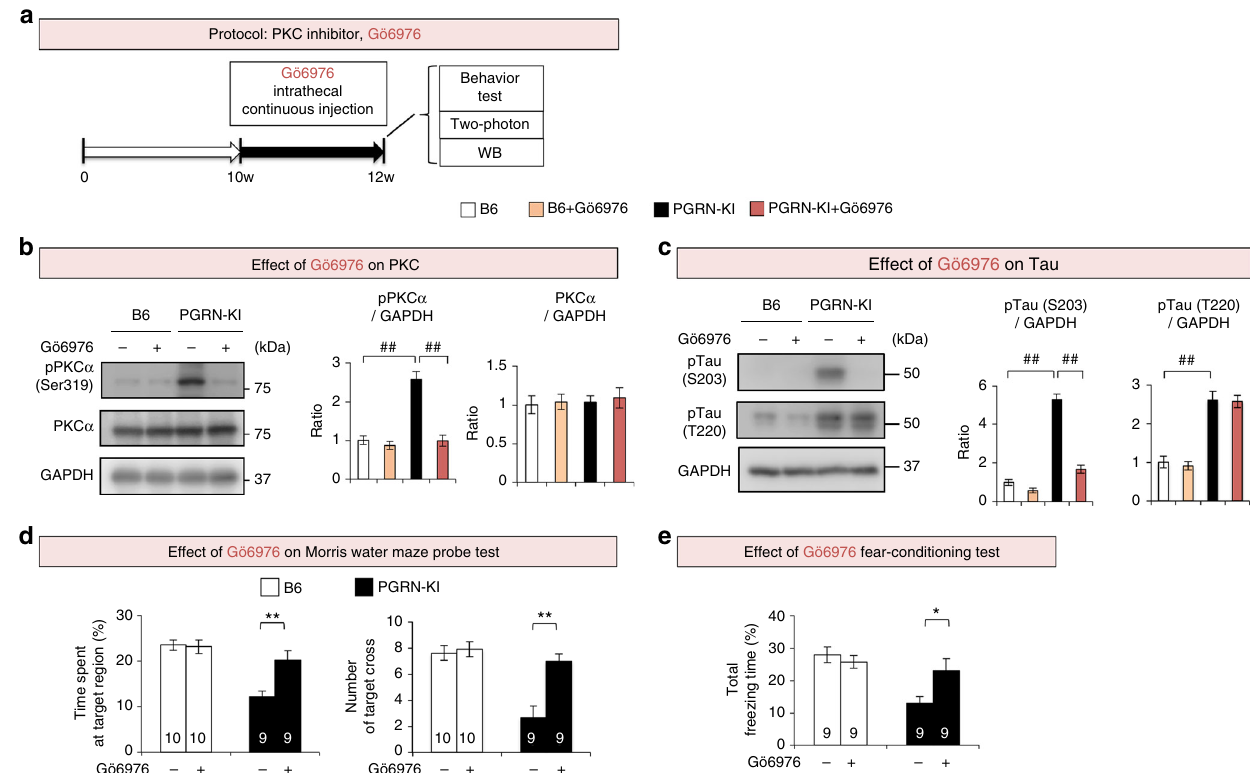
Fig. 7 Gö6976 rescues phosphorylation signals and phenotypes in PGRN-KI mice. a Experimental protocol for PKC inhibitor (Gö6976). Gö6976 (4.4 μ M) or PBS was injected via osmotic pump into the subarachnoid space of PGRN-KI and C57BL/6J mice from 10 to 12 weeks of age, and behavioral tests and western blots were performed at 12 weeks. b In vivo effect of Gö6976 on PKC α in cortical tissues of PGRN-KI mice. ## p < 0.01 ( N = 6, Tukey ’ s HSD test). Averages and s.e.m. are shown. c In vivo effect of Gö6976 on phosphorylation of tau in cortical tissues of PGRN-KI mice. Right panels show quantitation of western blot band intensities. ## p < 0.01 ( N = 6, Tukey ’ s HSD test). Averages and s.e.m. are shown. d In vivo effect of Gö6976 on two parameters (% time spent at target region and number of target crosses) in Morris water maze test. p -values were determined by Student ’ s t -test ( N = 10). Averages and s.e.m. are shown. e Effect of Gö6976 on % total freezing time in the fear-conditioning test. p -values were determined by Student ’ s t -test ( N = 9). Averages and s. e.m. are shown. p -values are shown in Supplementary Data and the resultant decrease in the number of dendritic spines. Together with previous observations made in relation to AD 46,49 , our results suggest that mislocalization of phosphorylated tau to spines is a common mechanism underlying synapse pathologies across multiple types of dementia.